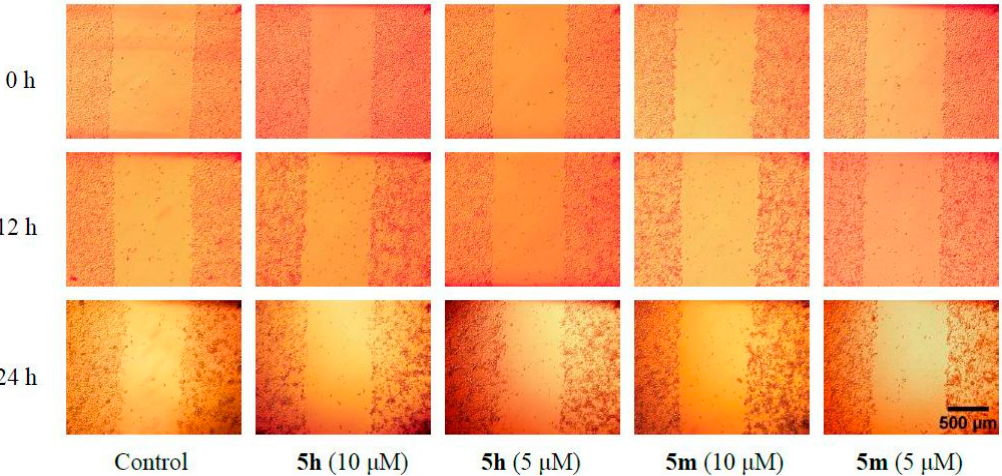
Figure 2. Images from a scratch assay experiment at different time points (0 h, 12 h, 24 h) and the cell migration process of Hela cells in response to different concentration of 5h and 5m.